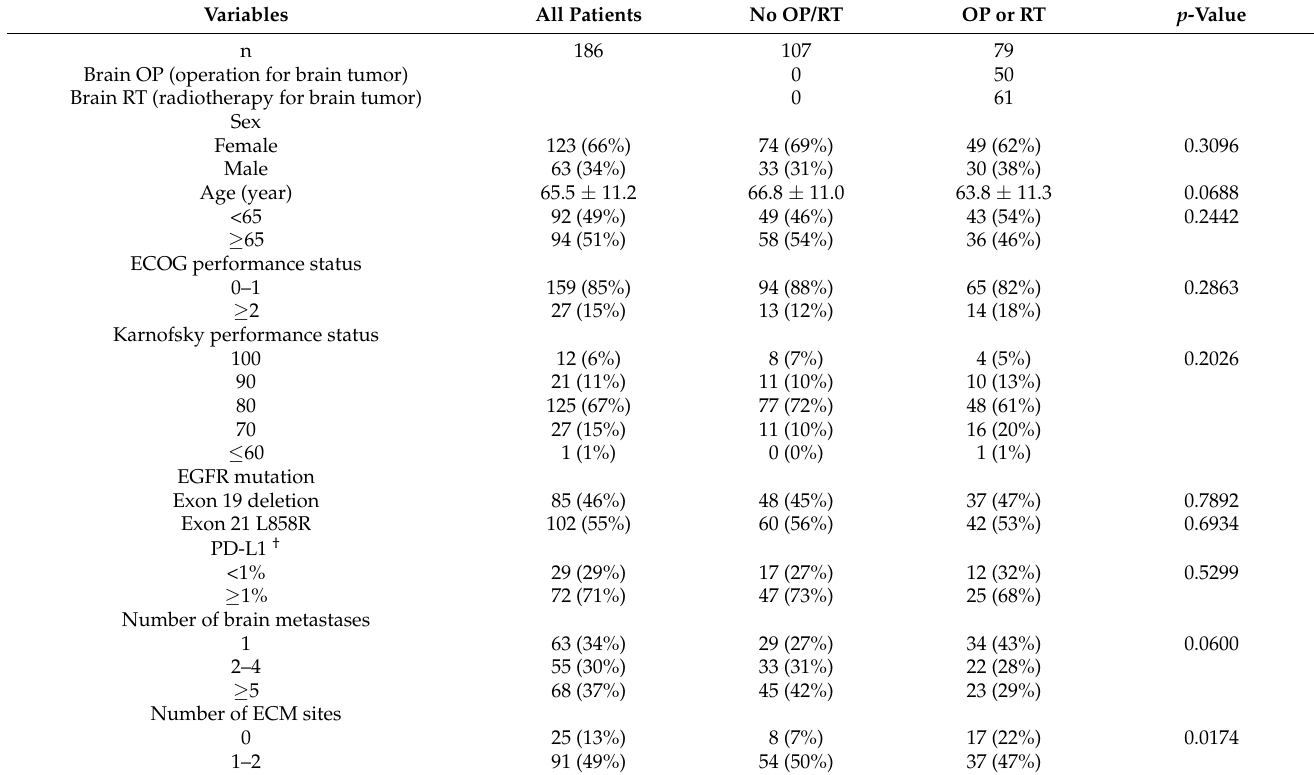
Table A2. Baseline characteristics of the study